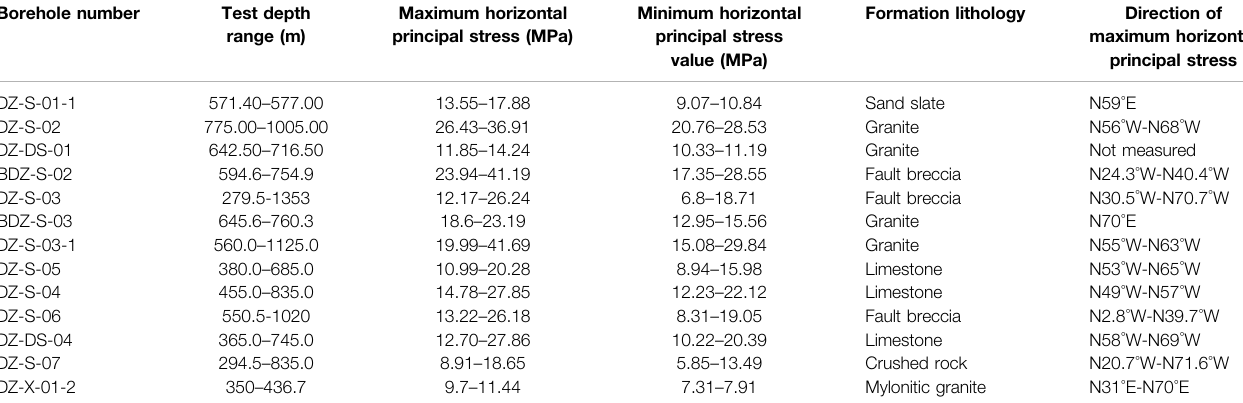
TABLE 1 | Statistical table of in-situ stress and rock types in the tunnel site of the Xianshuihe fault zone. Borehole number